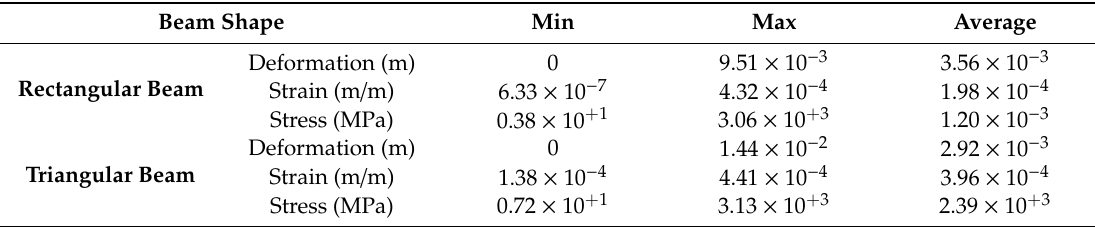
Table 2. Magnitudes of stress and strain with rectangular and triangular